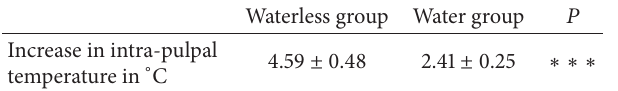
Shear bond strength (in MPa) ∗ ∗ ∗ Statistically significant ( ∗∗∗ 𝑃 < 0.05) changes. ± : standard deviation. Table 2: Intergroup comparison of the shear bond strengths of the groups. Tukey’s multiple comparison test Shear bond strength Control/water group ∗ ∗ ∗ Control/waterless group ∗ ∗ ∗ Waterless group/water group ∗ ∗ ∗ Statistically significant ( ∗∗∗ 𝑃 < 0.05) changes. Table 3: Comparison of mean increase in intra-pulpal temperature for the water and waterless groups. 𝑃 Increase in intra-pulpal 4.59 ± 0.48 ∗ ∗ ∗ temperature in ∘ C Statistically significant ( ∗∗∗ 𝑃 < 0.05)